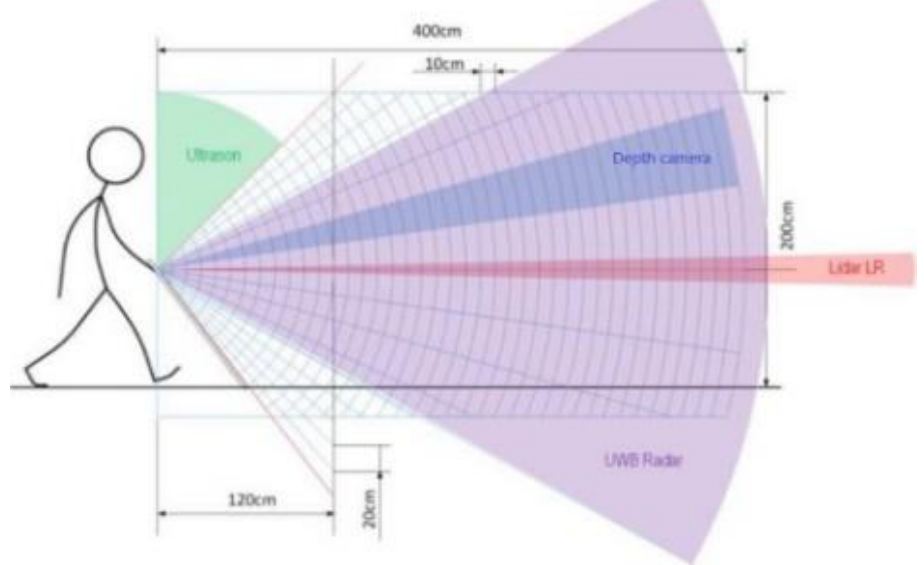
Figure 3. Arrangement of the sensors to cover the whole person’s height.